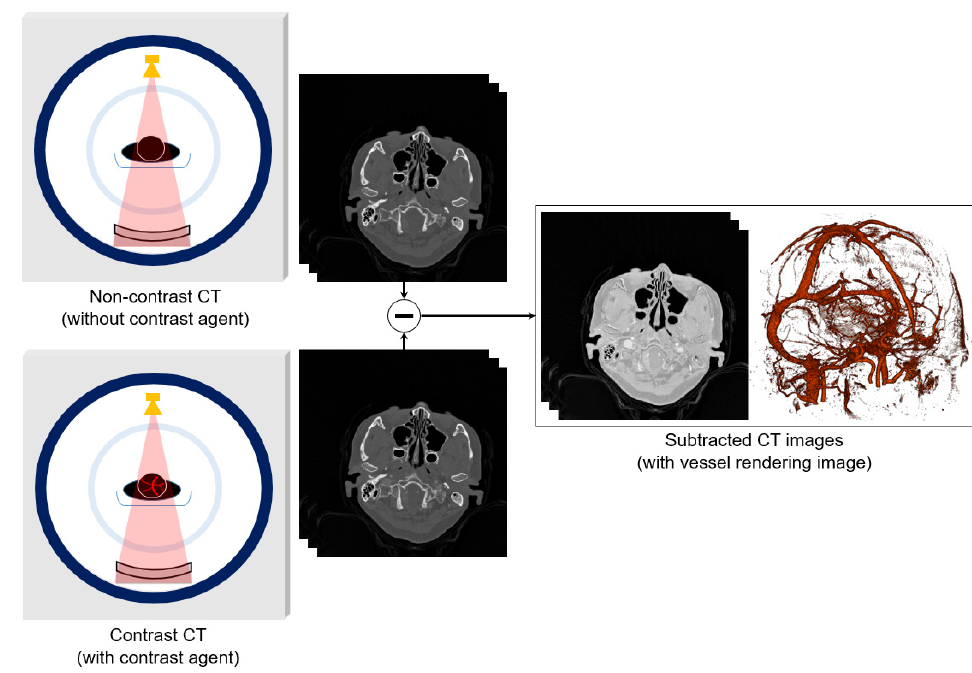
Figure 1. Acquisition of computed tomography angiography (CTA) images by directly subtracting non-contrast CT images without a contrast agent from contrast CT images. Vessel rendering showing segmentation of the subtracted CT images based on the Hounsfield unit (HU) values.